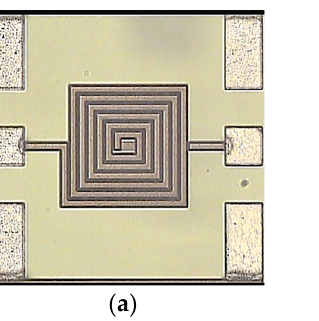
Figure 4. The die photos of the measured inductors. ( a ) The fixed-line-width inductor L1; ( b ) the variable-line-width inductor L2.